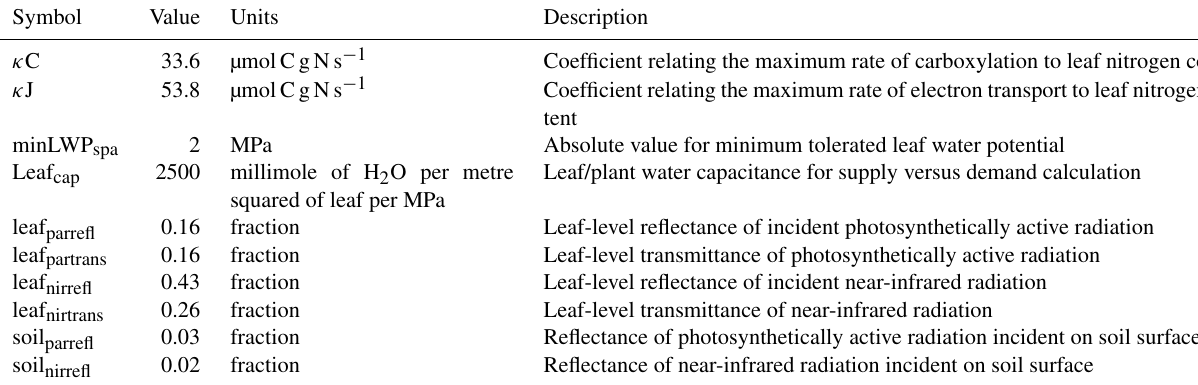
Table B1. Ecophysiological parameters used by SPA within this study but not already provided in Tables 2 and 3. These parameters are drawn from previous SPA publications (Williams et al., 1996; Bonan et al.,